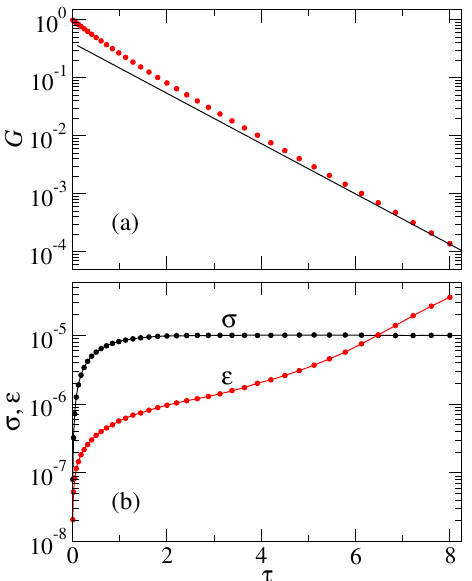
FIG. 24. The same kind of data as in Fig. 22 but obtained using a synthetic spectrum with a δ function of weight a 0 ¼ 0 . 4 at ω 1 and a continuum consisting of a half-Gaussian above the 0 ¼ δ function, of width 1. The straight line in (a) corresponds to the contribution from just the δ